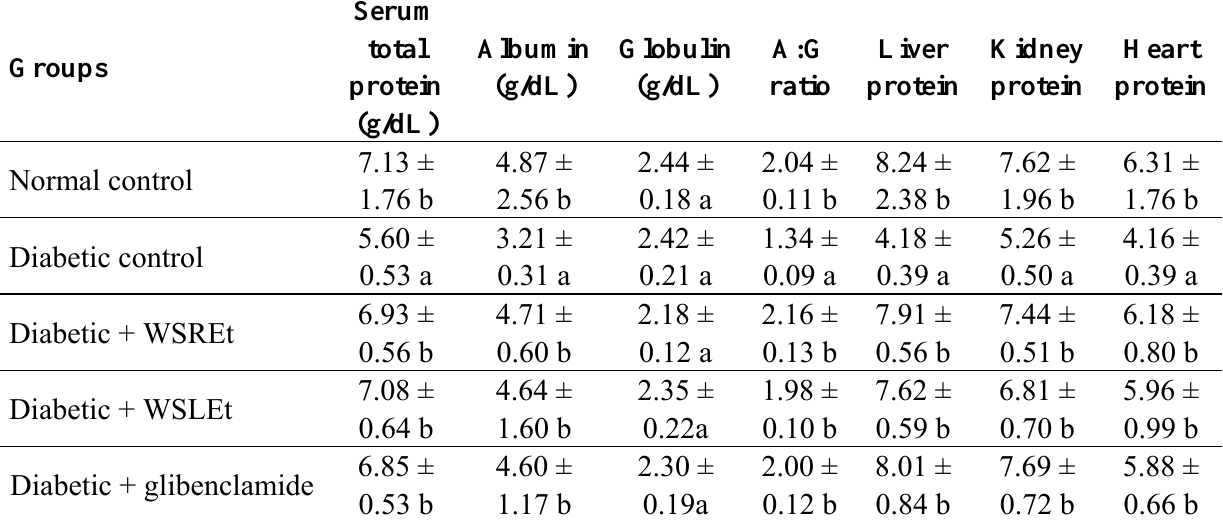
Table 7. Effects of W. somnifera (L.) extracts on serum and tissue (liver, kidney and heart)